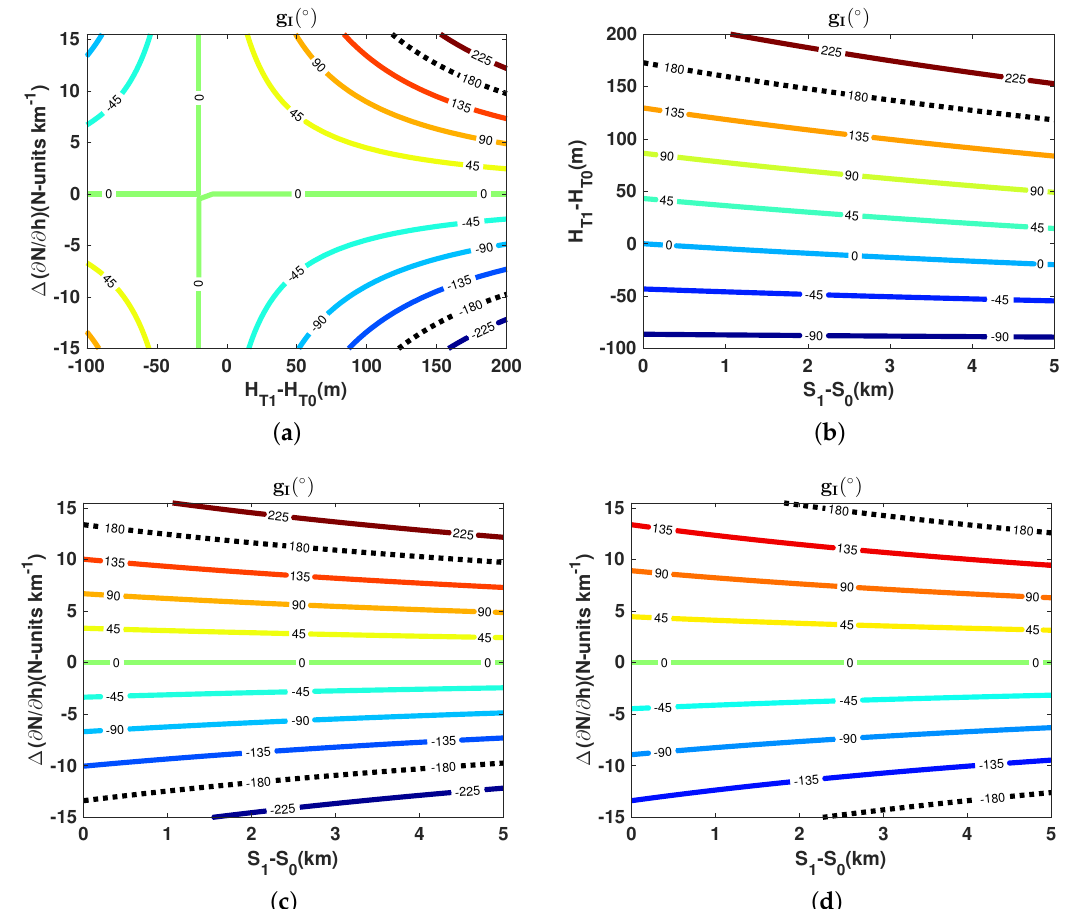
Figure A2. Contribution of g I ( ∆ [ ∂ n ( ∆ t ) / ∂ h ]) to the total phase variation. ( a ) g I ( ∆ [ ∂ n ( ∆ t ) / ∂ h ]) as a function of the vertical gradient variation and the height difference between targets. The arc distance from the radar to the first target and between targets are respectively set to 20 and 5 km; ( b ) g I ( ∆ [ ∂ n ( ∆ t ) / ∂ h ]) as a function of the arc distance and the height variations between targets. The vertical gradient variation is set to 15 N-units km − 1 ; ( c ) g I ( ∆ [ ∂ n ( ∆ t ) / ∂ h ]) as a function of the vertical gradient variation and the arc distance between targets with a height difference between targets of 200 m; ( d ) as in ( c ), but setting the height difference to 150 m. Height differences up to 200 m and arc distances between targets up to 5 km have been